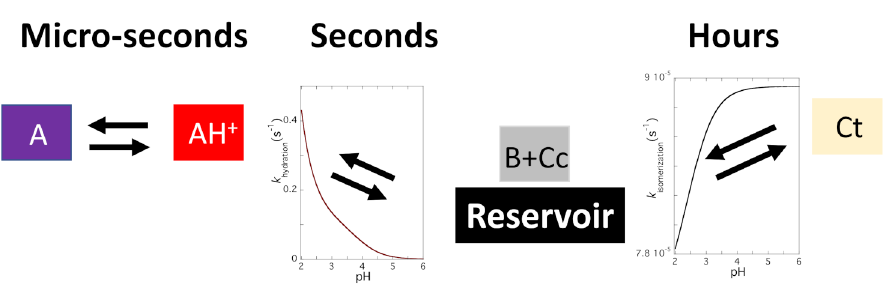
Scheme 7. Conversion rates between the colorless reservoir in anthocyanins and the colored species.